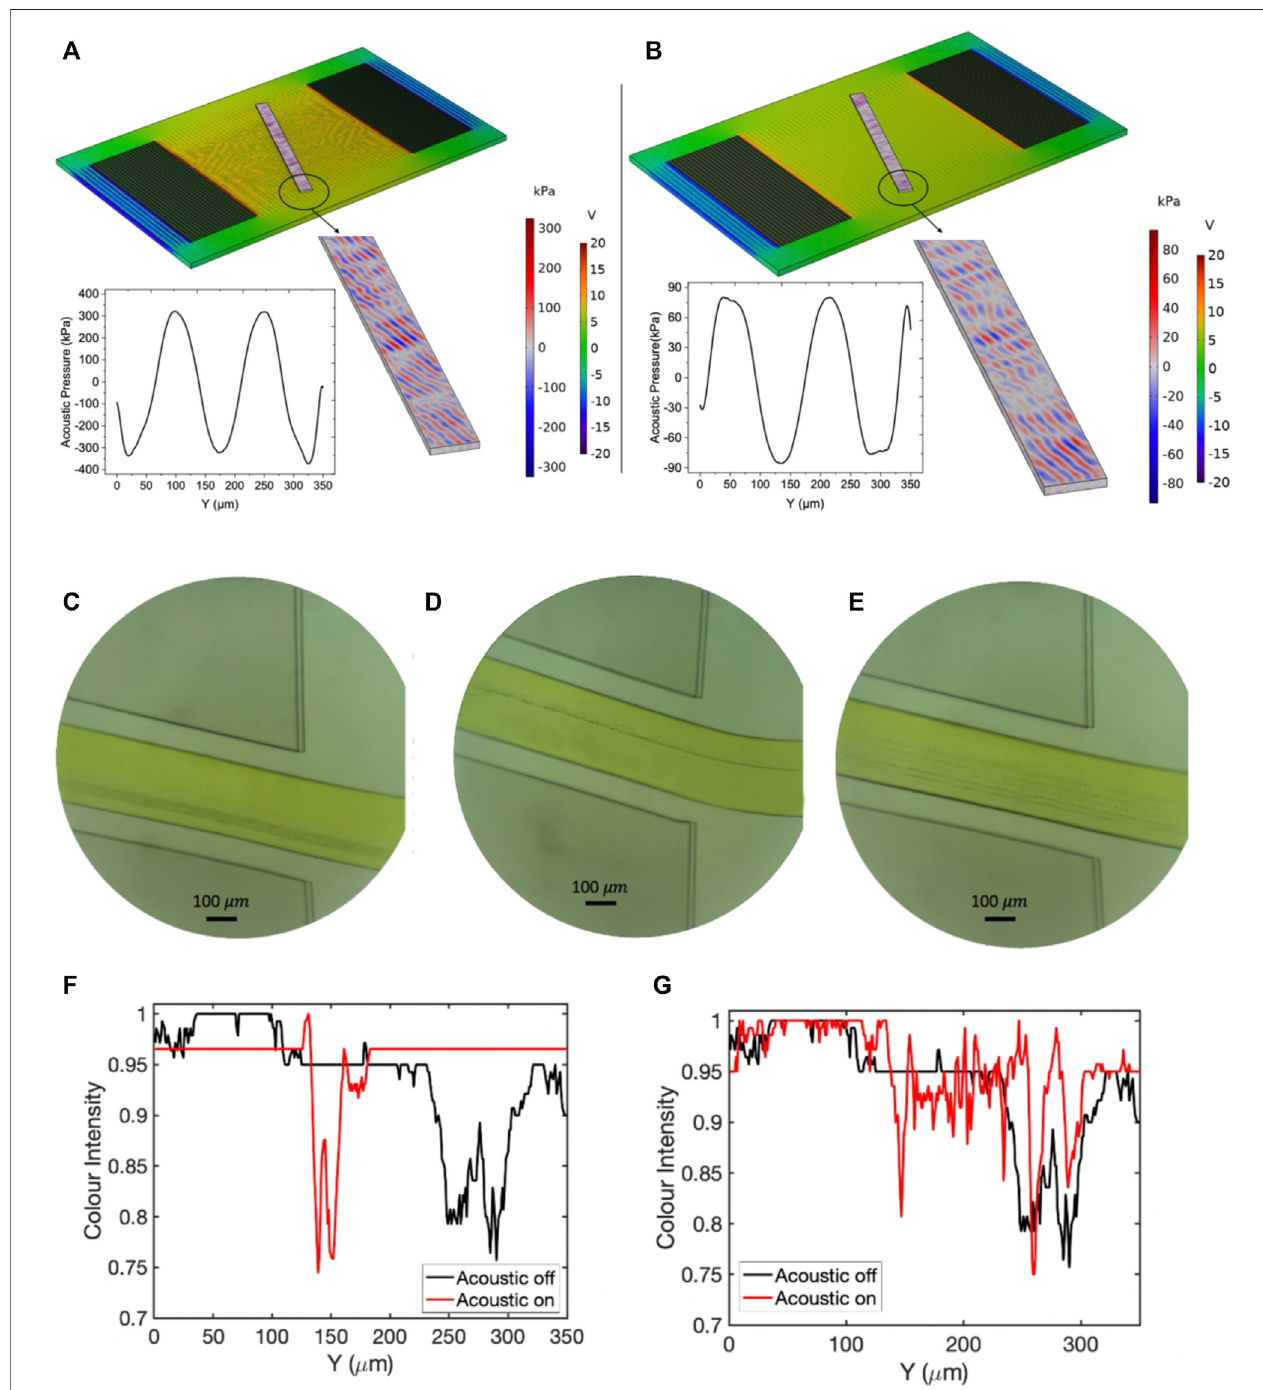
FIGURE 14 | The results of pressure distribution and experimental tests for experiment number 5 with Q-factor 78 in resonant frequency and 0 . 5 MHz deviation fromresonantfrequency. (A) Thedistributionofpressureandvoltageacrossthemicrochannelinresonantfrequency. (B) Thedistributionofpressureandvoltageacross the microchannel with 0 . 5 MHz deviations from resonant frequency. (C) Sheath fl ow focusing of the stream of 0 . 5 μ m particles before SSAW excitation. (D) Microbead focusing fl owpathafter SSAW excitation inresonantfrequency. (E) Particle fl owpath after SSAWexcitationin0 . 5 MHz off-resonantfrequency. (F) Graph ofcolour intensity before and after acoustic actuation in resonant frequency (G) Graph of colour intensity before and after acoustic actuation in off-resonant frequency.